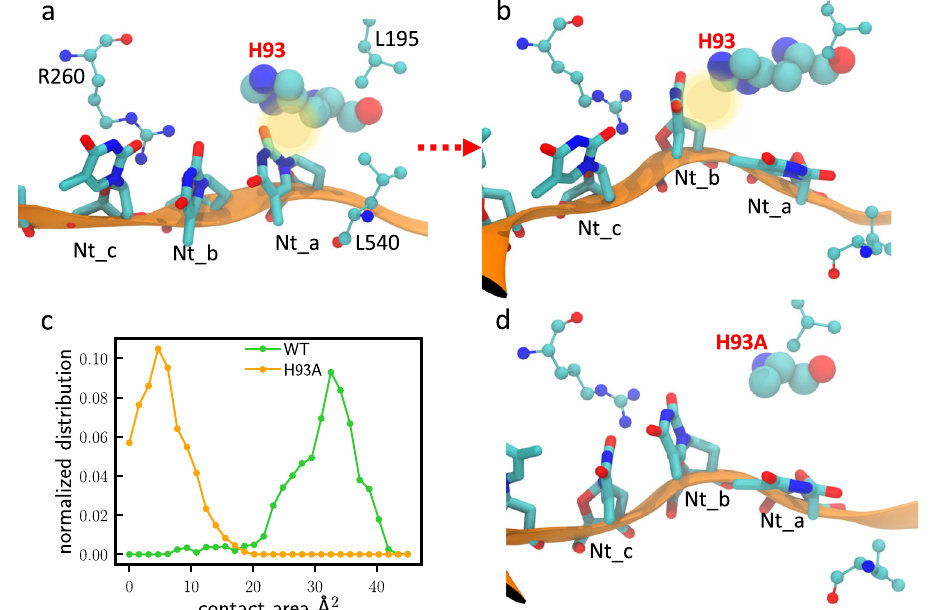
c Distributions for the contact areas at the fi nal state (green curve for Nt_b - H93; orange curve for Nt_b - H93A). d ssDNA-PcrA interactions at the fi nal state for the H93A